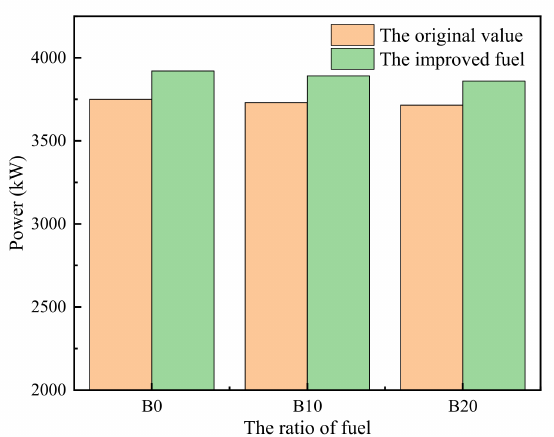
Figure 6. Comparison between the improved power and the original value under 75%